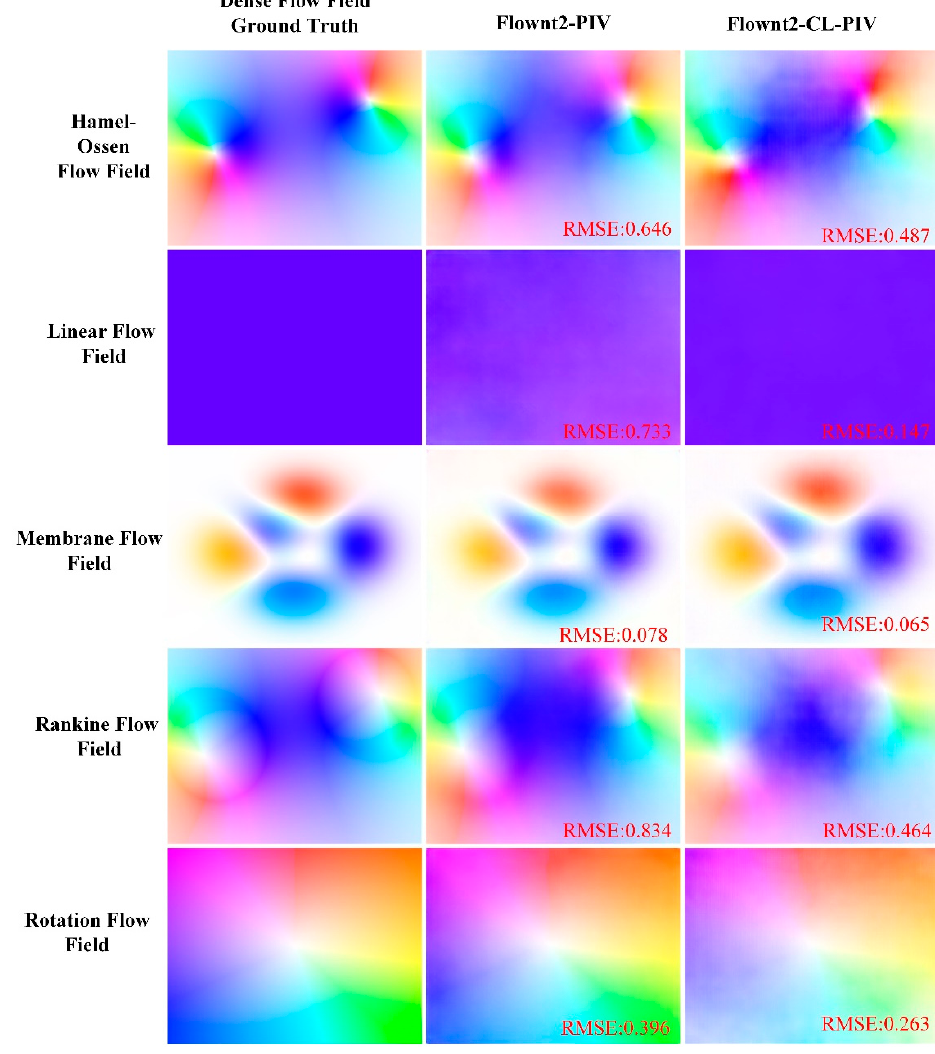
Figure 5. RMSE results of two methods on different flow fields.